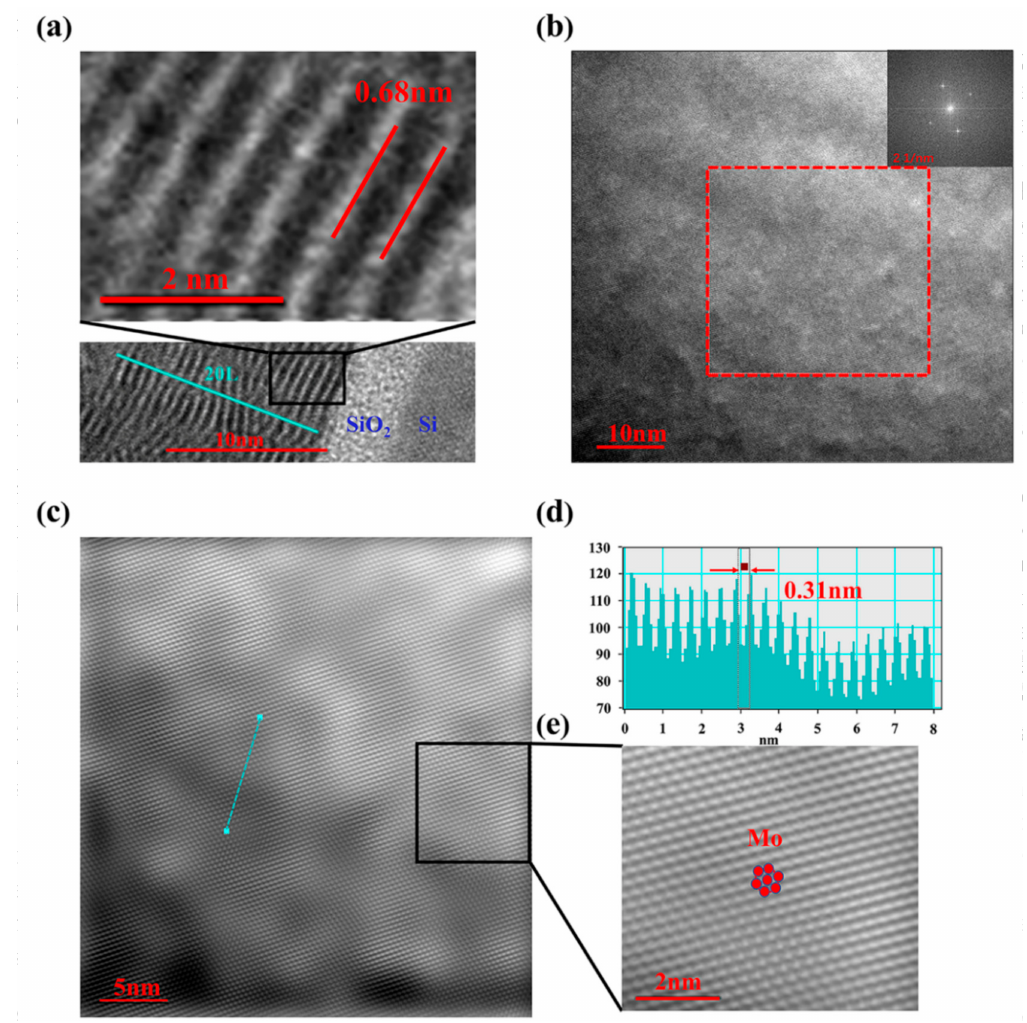
Figure 5. ( a ) Cross-sectional high-resolution field emission transmission electron microscope (HRTEM) image of samples deposited under an RF power of 120 W. ( b ) High resolution TEM image of the MoS 2 film deposited by 120 W RF power transferred onto a lacey carbon grid. The inset shows the fast Fourier transformation (FFT) image corresponding to the TEM image selected area of a portion of ( b ), showing the hexagonal symmetry of the MoS 2 structure. ( c ) Inverse FFT images corresponding to the TEM image selected area of a portion of ( b ). ( d ) Atomic spacing along the selected direction of the basal plane. ( e ) Zoom-in image of the area highlighted in ( c ). The hexagonal structure formed by Mo atoms is